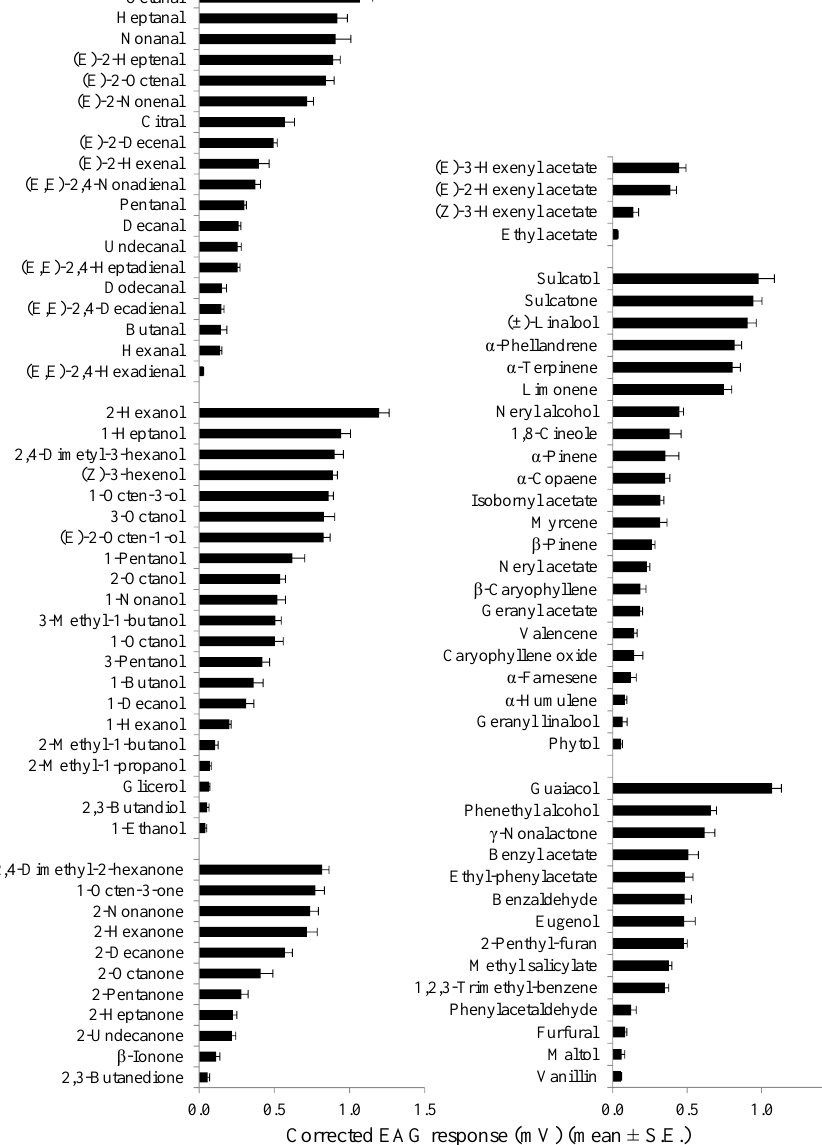
Figure 3. EAG response profile of male A. bungii distal flagellomeres (seventh to ninth) to a range of VOCs. Within each chemical group, compounds are listed according to the mean amplitude of the EAG response (n = 5) elicited at the 1 mg dose.